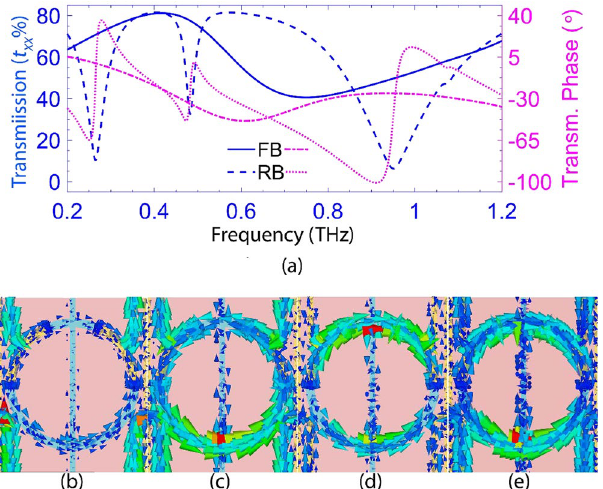
Figure 4. ( a ) The co-polarized transmission amplitude spectra at the forward (solid blue) and reverse (dashed blue) and phase spectra at the forward (magenta dotted-dashes) and reverse (magenta dots), ( b )–( d ) the surface current distributions at the dipole resonance of 0.26 THz and LC resonance frequencies of 0.48 and 0.95 THz, obtained in the reverse bias, ( e ) the surface current distributions at the dipole resonance frequency of 0.74 THz obtained at the forward bias.